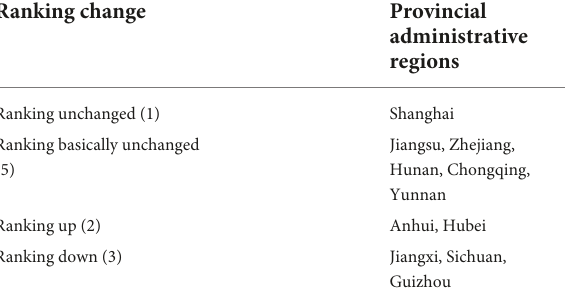
TABLE 3 Changes in the ranking of comprehensive efficiency of the Yangtze River Economic Belt from 2011 to 2019. Ranking change Provincial